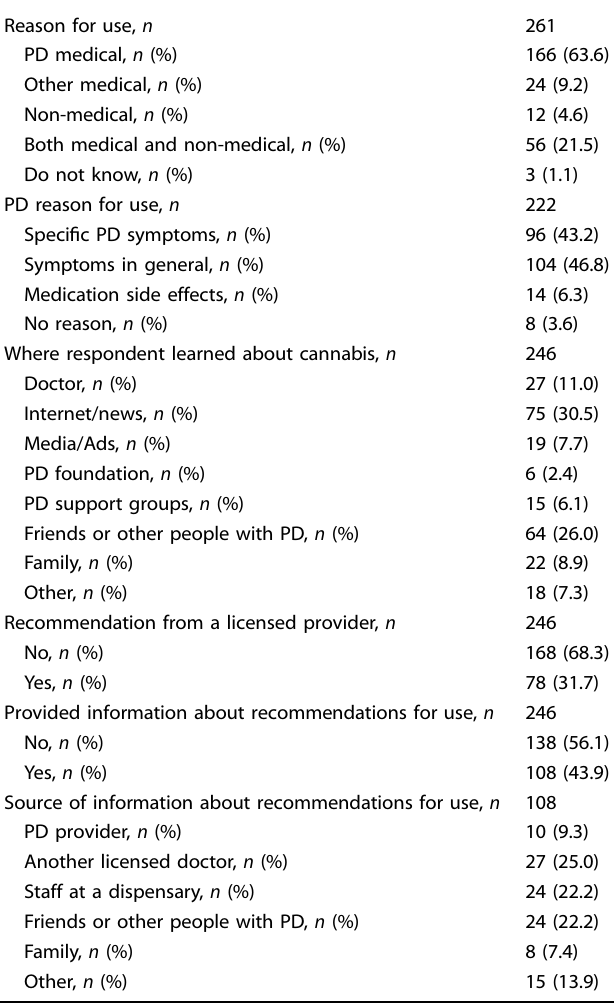
Table 3. Reasons for Cannabis use.